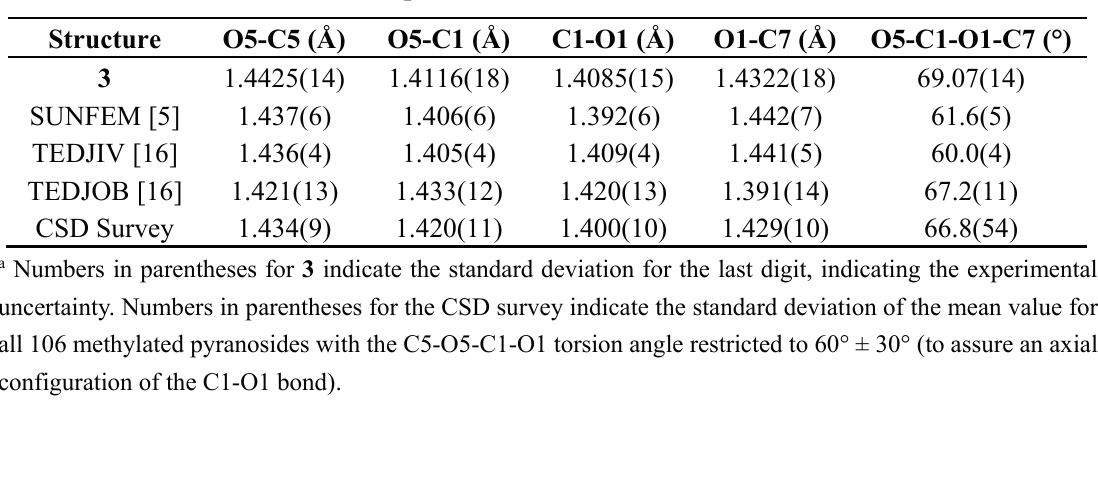
Table 4. Properties around the anomeric center a